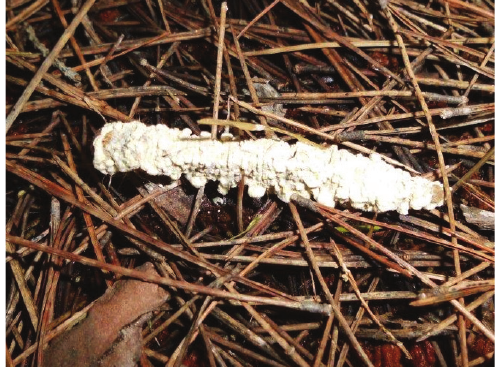
figUre 2. Dendrolimus pini larva covered with white mycelium of Beauveria bassiana fungus found on the soil surface.